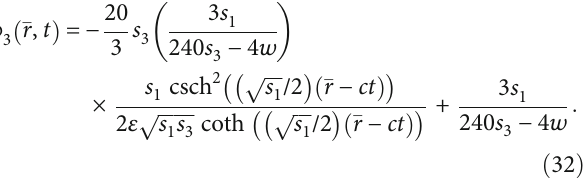
Figure 3: Graphical behavior for ϕ s = 1, and w = 1 3